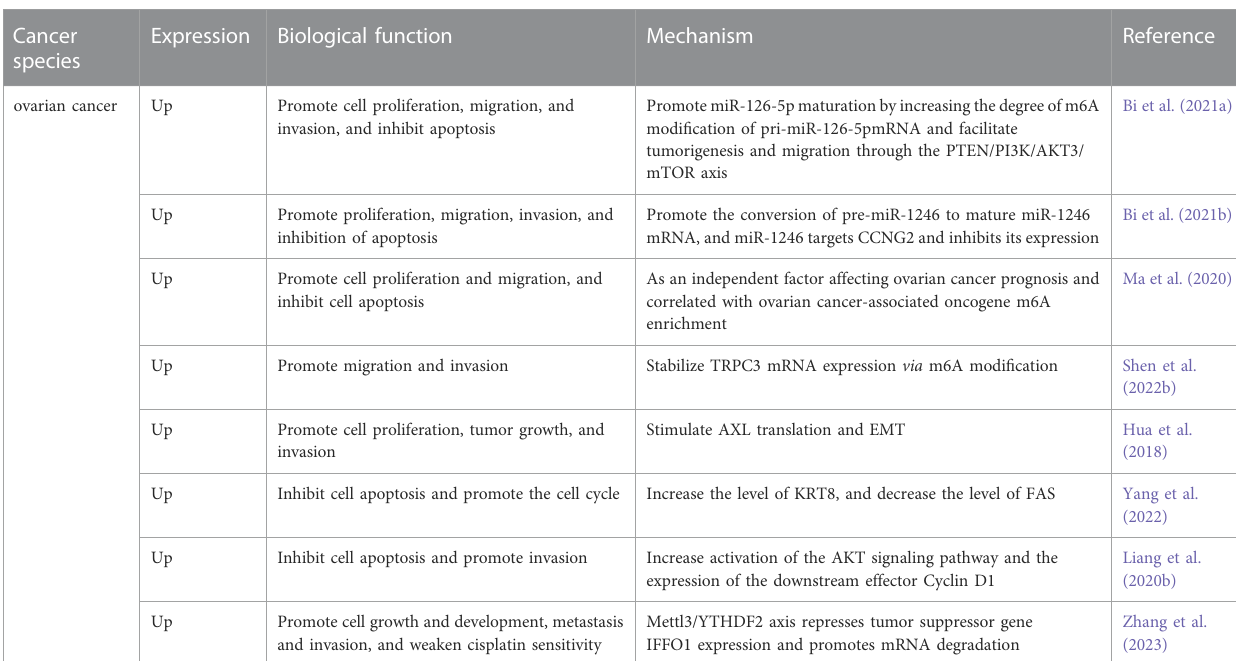
TABLE 2 The role of Mettl3 in ovarian